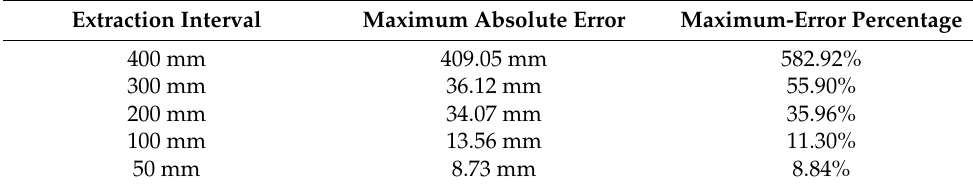
Table 2. Comparison of maximum-absolute-error value and maximum-error percentage under different intervals.